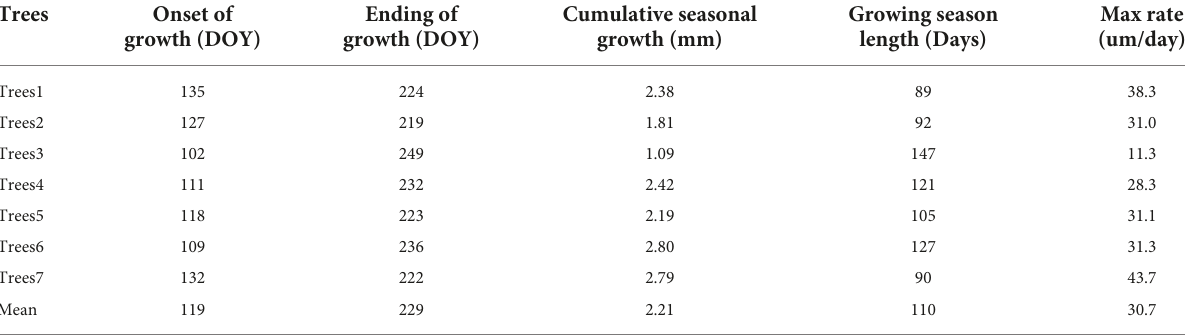
TABLE 1 Parameters estimated from the Gompertz